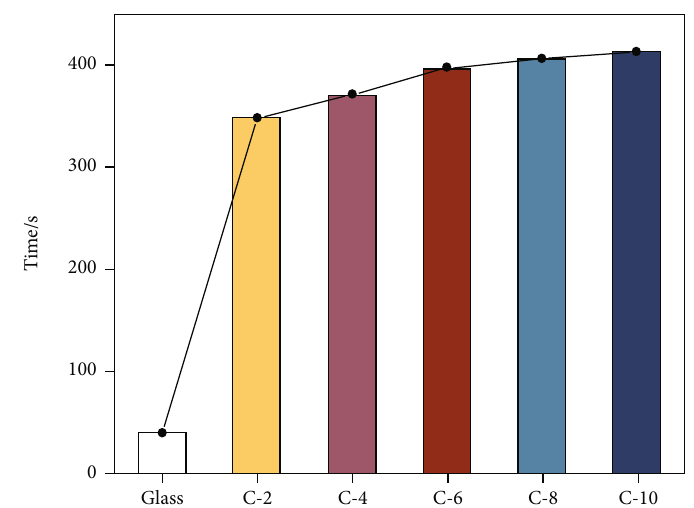
Figure 3: Freezing time on the surface of CNT nanocomposite photothermal